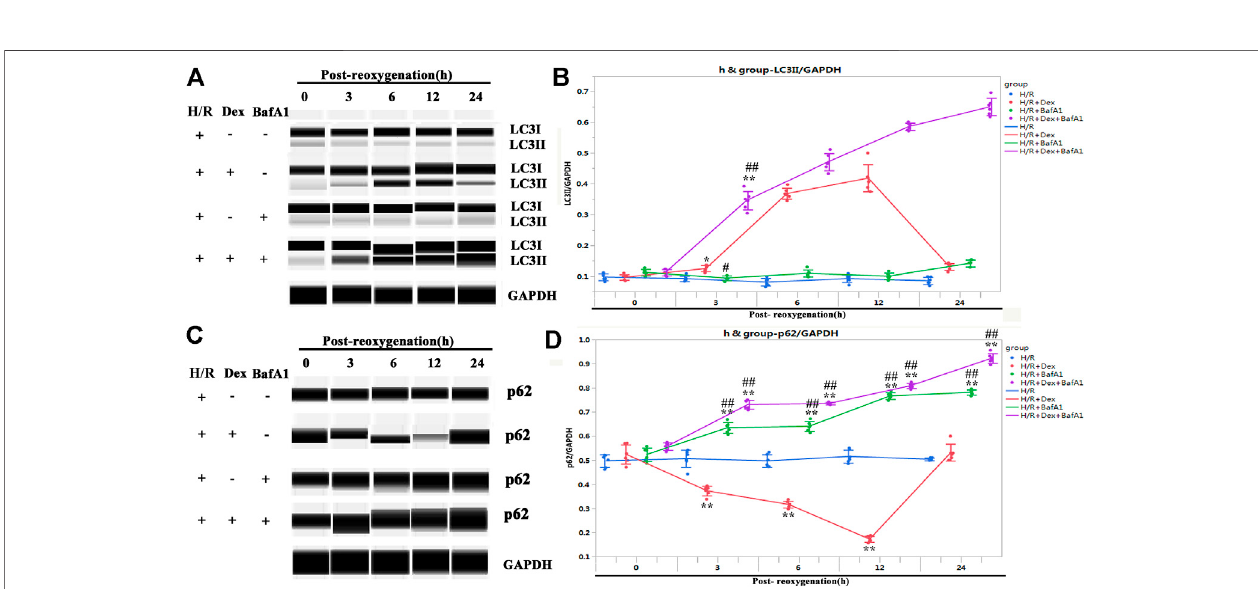
FIGURE5| Dexactivatedautophagybutdidnotblockautophagosomalmaturation. (A) RepresentativeLC3IIWesblotofiPSC-CMpretreatedwithDexandBafA1 (the inhibitors of autophagosomal maturation). (B) Quanti fi cation of the LC3II relative expression. N (cid:2) 6 replicates. (C) Representative p62 Wes blot of the iPSC-CM pretreated with Dex and BafA1. (D) Quanti fi cation of the p62 relative expression. N (cid:2) 6 replicates. * p < 0.05, ** p < 0.01. vs. H/R; ## p < 0.01, vs. H/R + Dex.